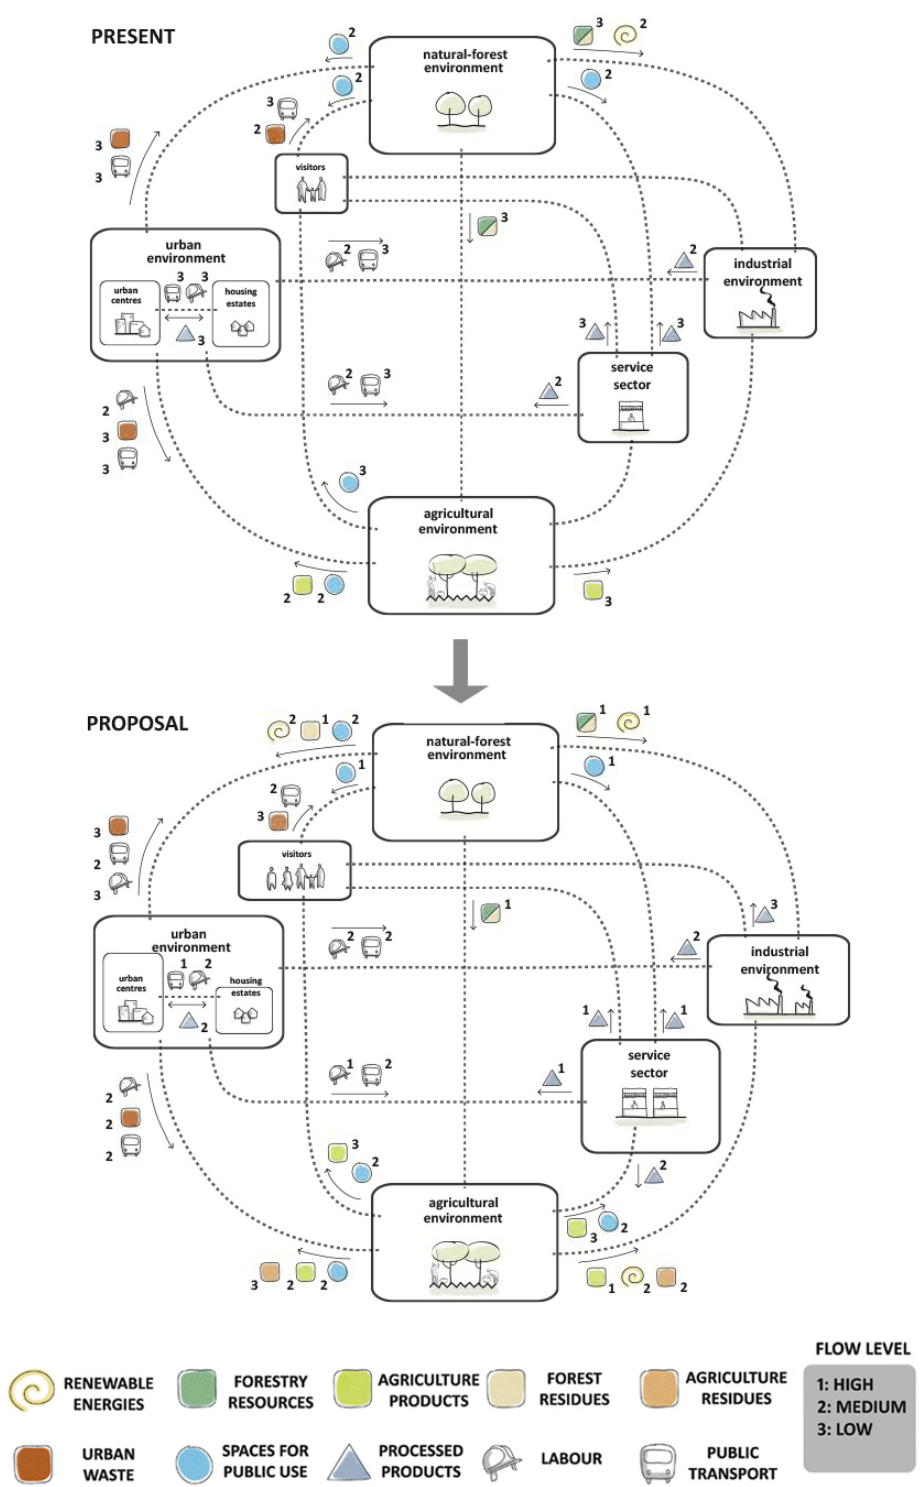
Figure 9. Regional model: Potential improvements of metabolic cycles in the Sierra Calderona region. Source: Galan